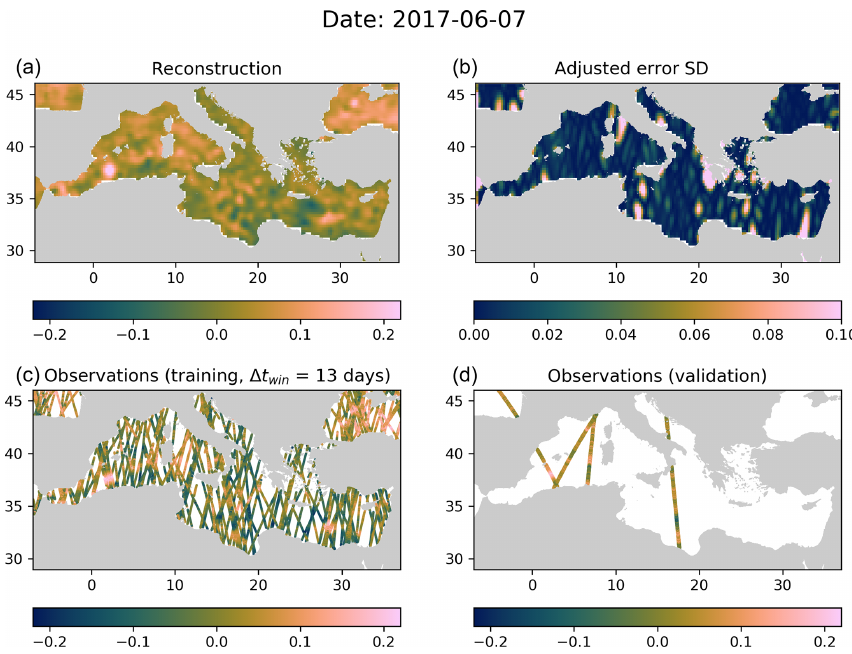
Figure 7. Panel (a) Reconstructed SLA by DIVAnd, (b) expected error standard deviation by DIVAnd (with adjustment), (c) data used during training (partial) and (d) independent data for validation withheld during analysis. All panel values are in meters.